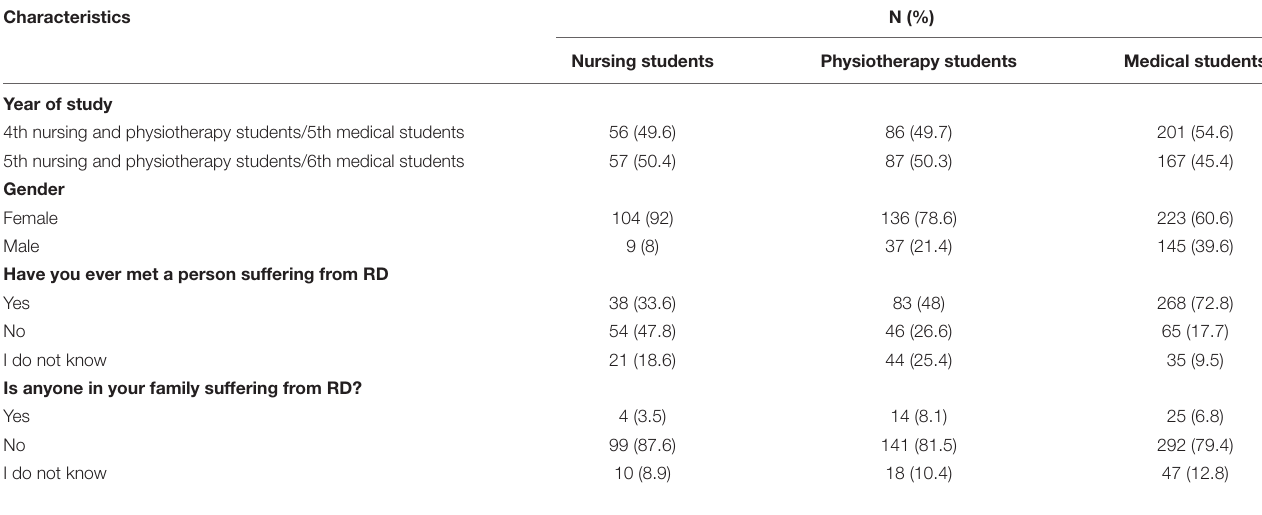
TABLE 1 | Socio-demographic characteristics of